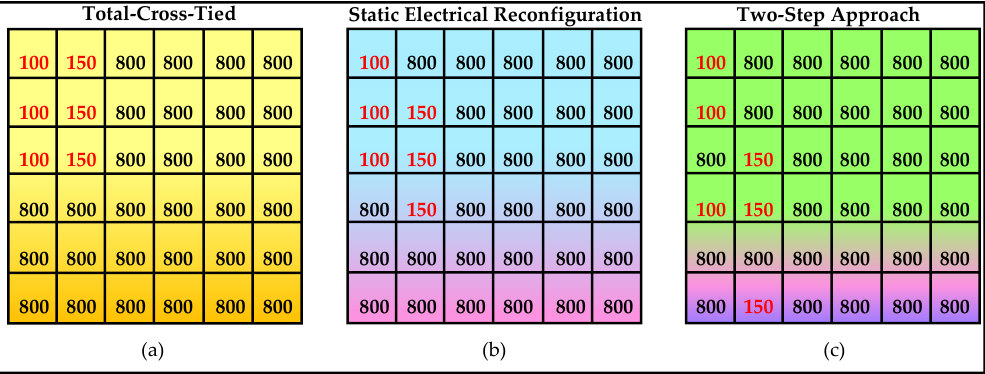
Figure 7. Irradiance received by the 6 × 6 PV array during partial shading S1 for ( a ) conventional, hybrid and TCT, ( b ) static electrical reconfiguration (shade dispersion), and ( c ) the two-step approach (shade dispersion).